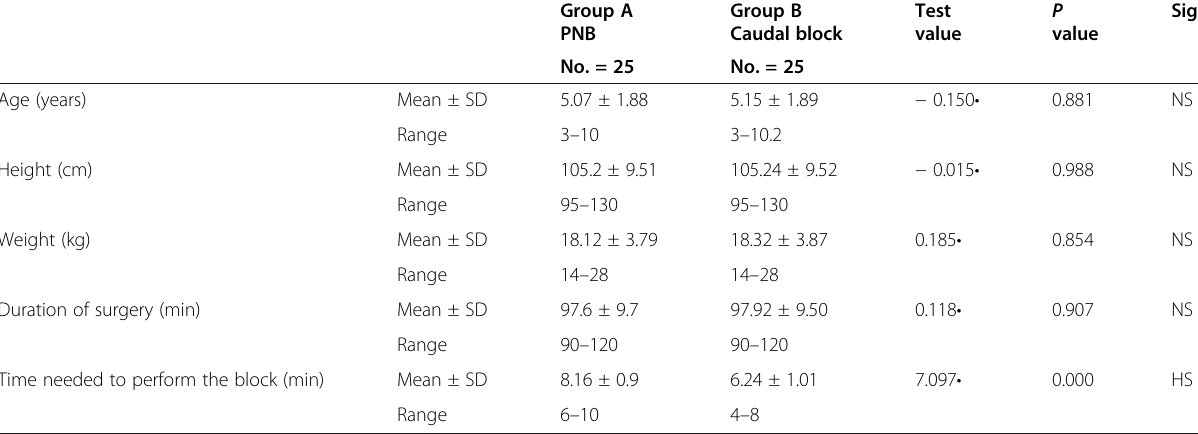
Table 2 Comparison between group A and group B regarding characteristics of the studied patients, duration of surgery, and time needed to do the